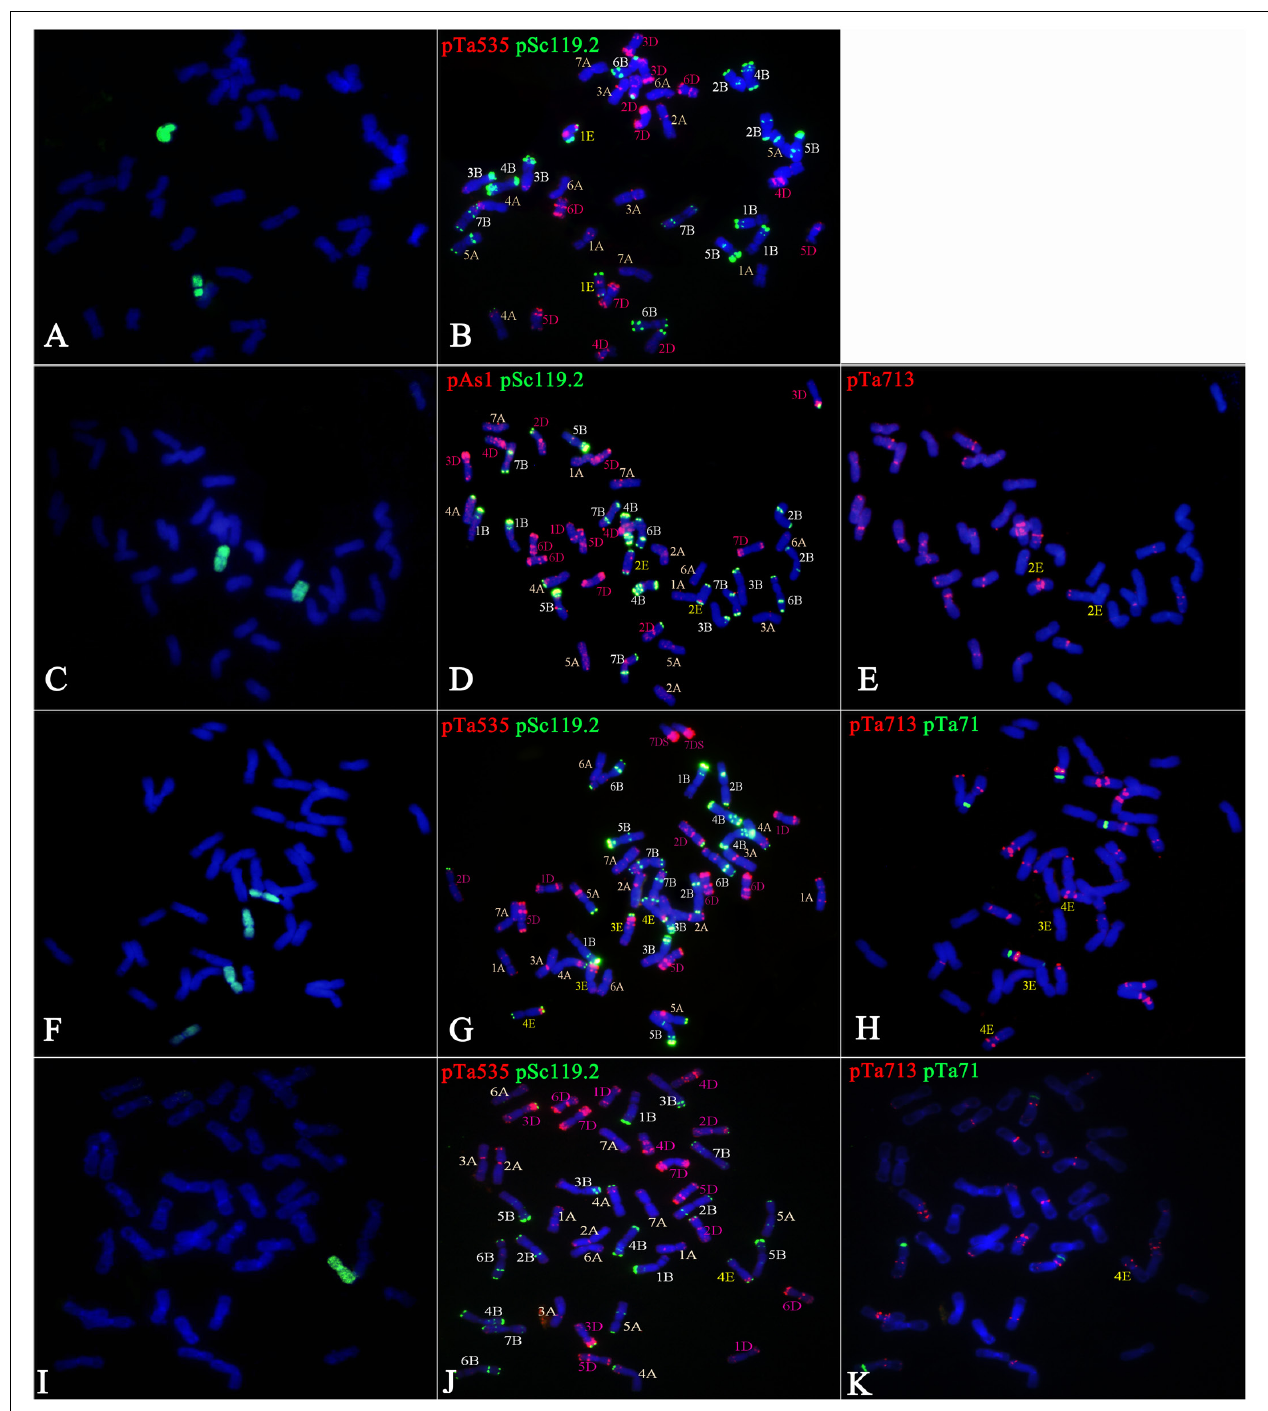
FIGURE 4 | Chromosome identification of hybrid progenies. Images on the right of each panel show FISH results using pSc119.2 (green), pTa535 (red), pAs1 (red), pTa713 (red), and pTa71 (green), and those on the left show corresponding GISH patterns. Chromosomes in blue and green are wheat and Th. elongatum chromosomes in the GISH patterns, respectively. (A,B) Line K16-712-1-2 had a complete set of 28 A/B chromosomes, 12 D (2D-6D) chromosomes, and a pair of 1E chromosomes. (C–E) Line K16-681-4 had 13 A (lacking one 3A), 16 B (four 7B), 13 D (lacking one 1D), and one pair of 2E chromosomes. (F–H) Line K16-562-3 had all 28 A/B chromosomes, 10 D (1D, 2D, 5D, 6D, and 7D) chromosomes, and a pair each of 3E and 4E chromosomes. (I–K) Line K17-1089-1 had a complete set of 42 A/B/D chromosomes and one 4E chromosomes.